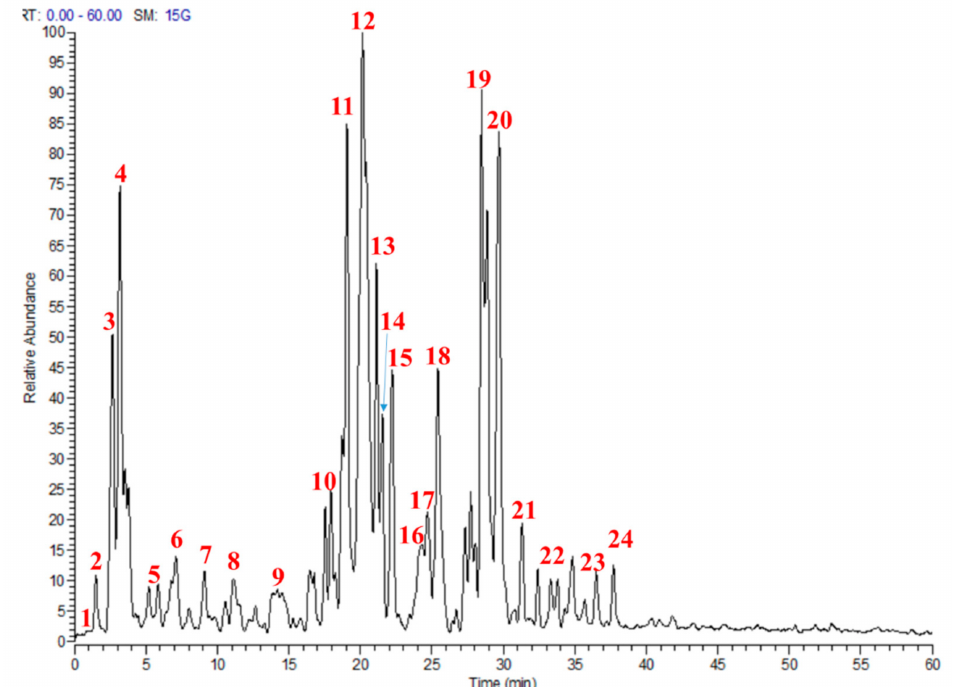
Figure 1. Profile of the active fraction from Moricandia sinaica aerial parts (MS-3) using liquid chromatography-mass spectrometry (LC-MS). Numbers in the figure match numbers of secondary metabolites in Table